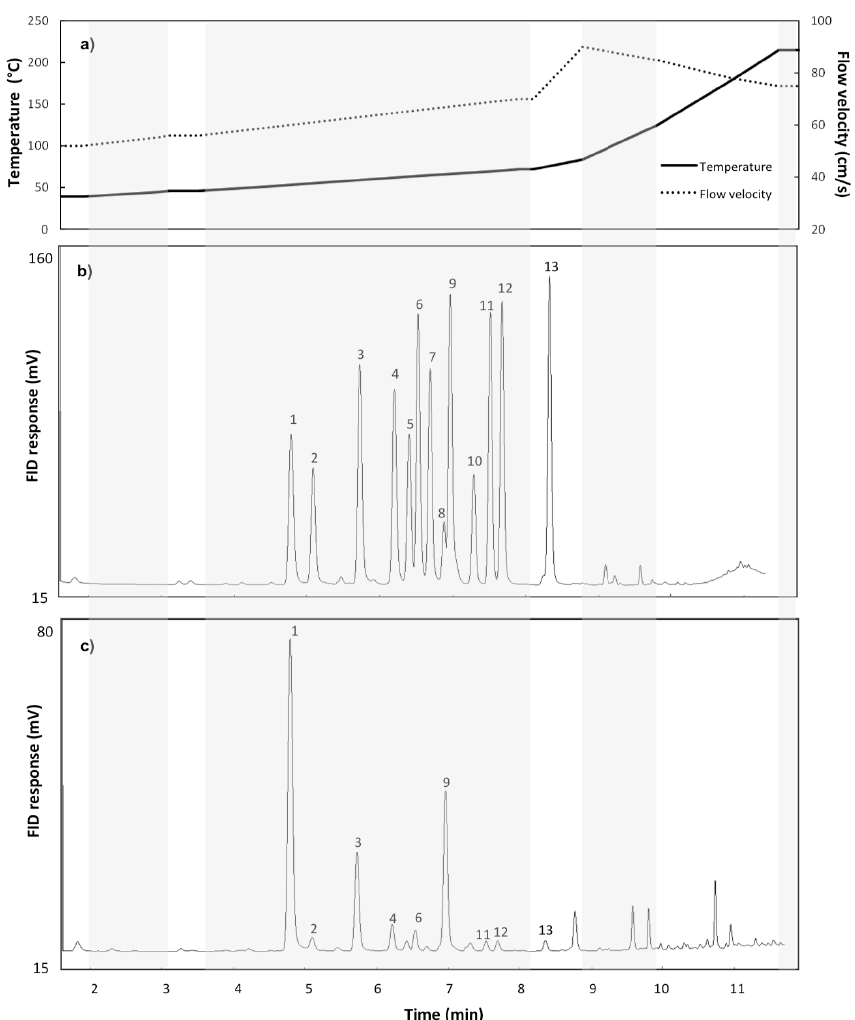
Fig. 3. (a) shows the GC_AMBIENT I method temperature and carrier gas flow velocity programmes. (b) shows a chromatographic trace recorded using the GC_AMBIENT I method for analysis of a monoterpene liquid standard ( ∼ 1.0–5.0mgL − 1 monoterpenes in isop-propyl alcohol). (c) shows a chromatogram recorded using this method to analyse monoterpenes in a discrete canister sample containing clean air (anthropogenic VOC close to or below instrument detection limit) from a pine forest in Ibaraki prefecture, Japan. Chromatographic peaks correspond to the following monoterpenes; α -pinene(1), camphene(2), β -pinene(3), myrcene(4), α -phellandrene(5), 1 -3-carene(6), α -terpinene(7), p-cymene(8), limonene(9), ocimene(10), unidentified terpene(11), γ -terpinene(12), terpinolene(13). Alternate shaded regions highlight changes in chromatography parameters (for more details, see Table